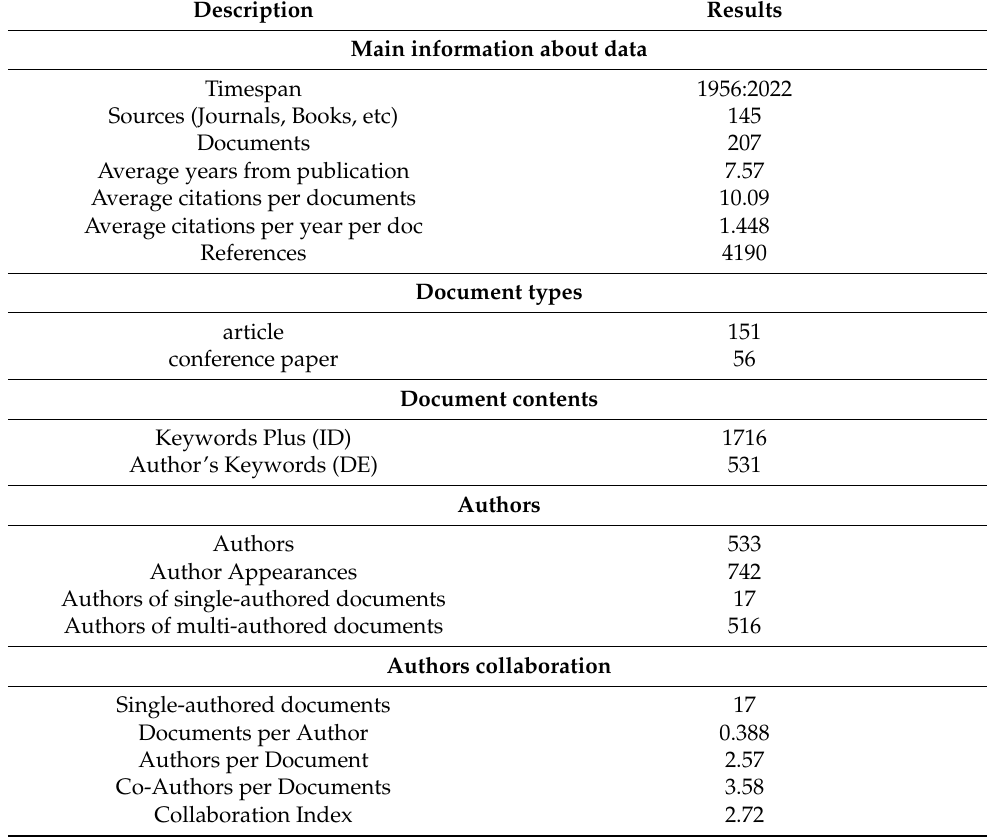
Table 1. Main information about data and